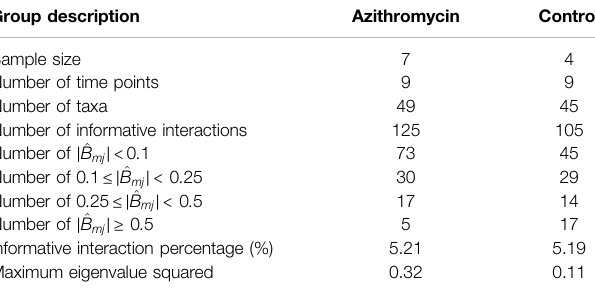
TABLE 2 | The characteristics of